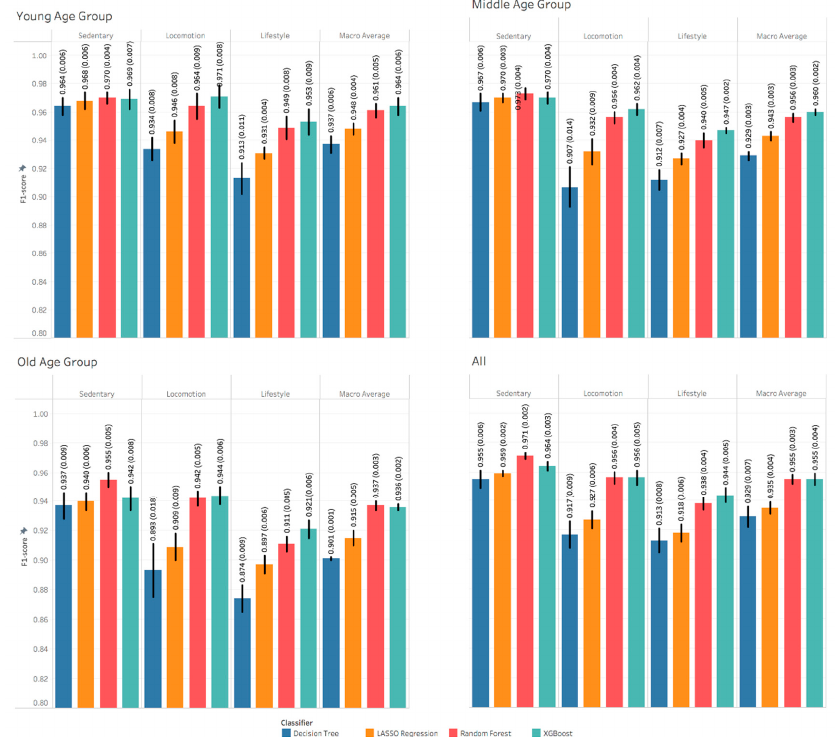
Figure 2. The F1-Scores of recognizing physical activity type. Each value is the mean and standard deviation of the 5-fold nested cross validation. Table 2. Participants descriptive characteristics by age group.